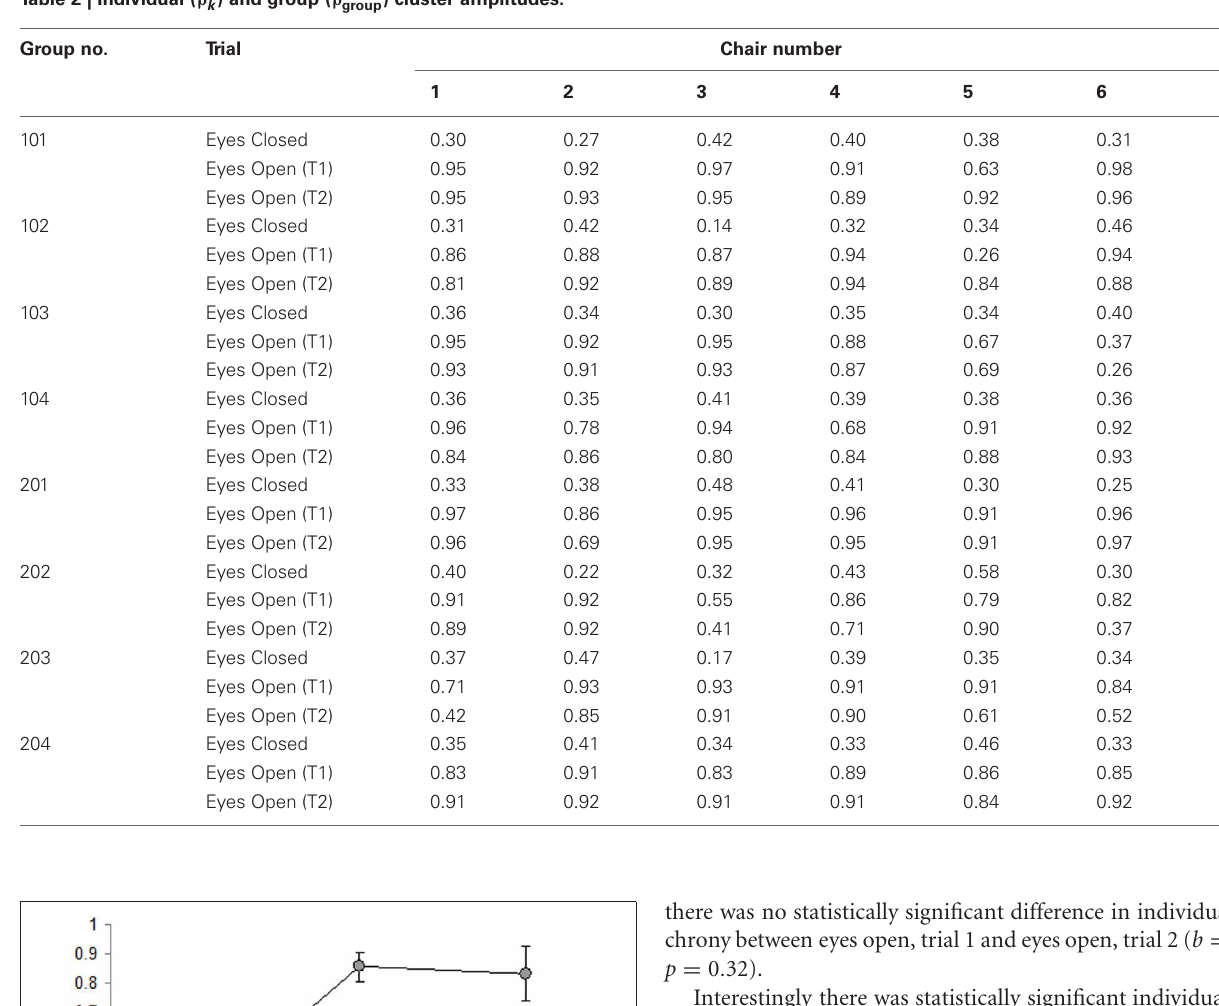
group is level 2). The variable Condition (fixed effect at level